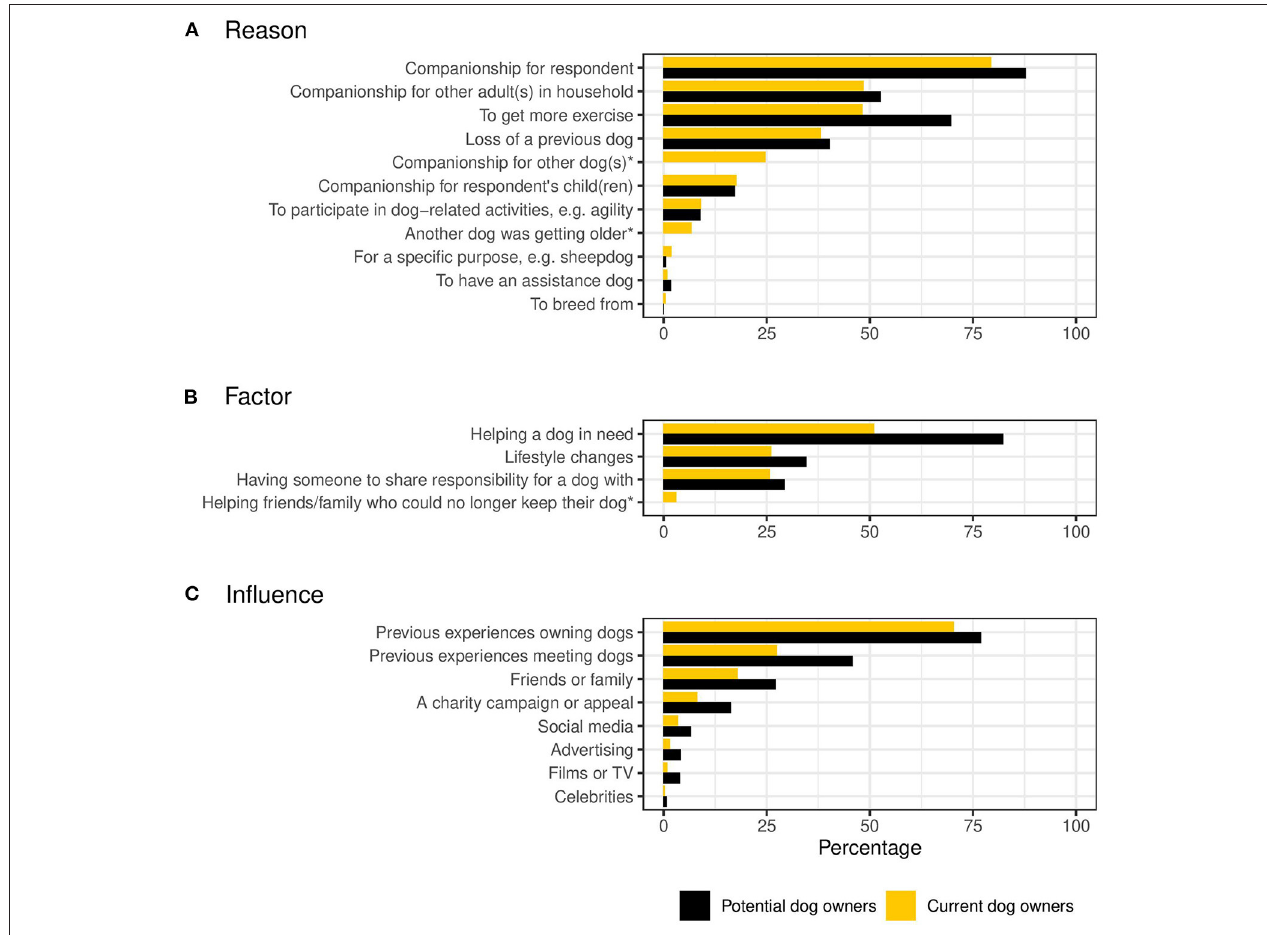
FIGURE 2 | Reasons, factors and influences reported by the current owner group and the potential owner group. The asterisks (*) indicate response options that were only displayed to the current owner group. Motivational factors associated with dog acquisition as reported by the current owner group and the potential owner group. (A) Reasons for acquiring a dog. (B) Factors associated with the decision to acquire a dog. (C) Influences associated with the decision to acquire a